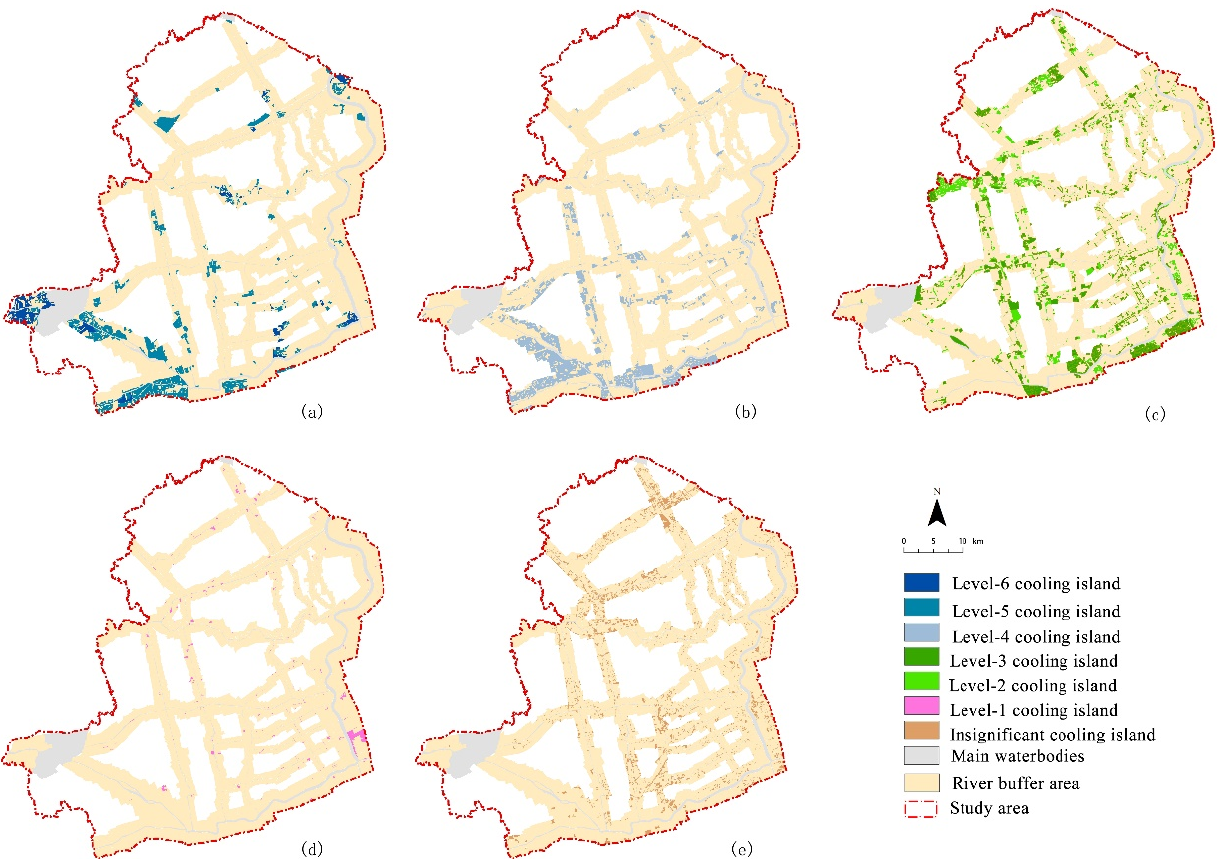
Figure 7. Spatial distribution of CI at different levels. ( a ) Level-six and level-five CI; ( b ) level-four cold island; ( c ) level-three and level-two CI; ( d ) level-one CI; ( e ) insignificant CI.